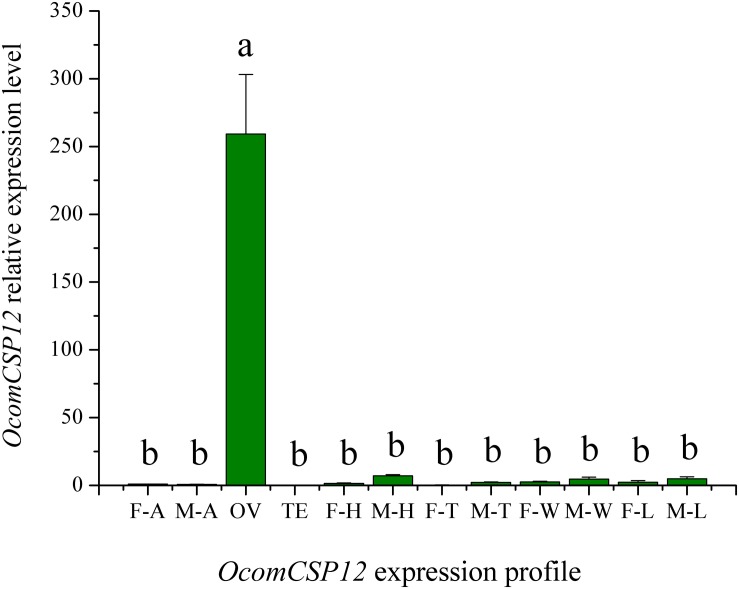
Expression pattern of OcomCSP12 in different male and female tissues. F-A, female antennae; M-A, male antennae; OV, female ovaries; TE, male testis; F-H, female heads; M-H, male heads; F-T, female thoraces; M-T, male thoraces; F-W, female wings; M-W, male wings; F-L, female legs; M-L, male legs. All expression fold changes are related to female antennae. Bars with the same letter are not significantly different from each other at P < 0.05 based on LSD test. Each point represents mean ± SE.